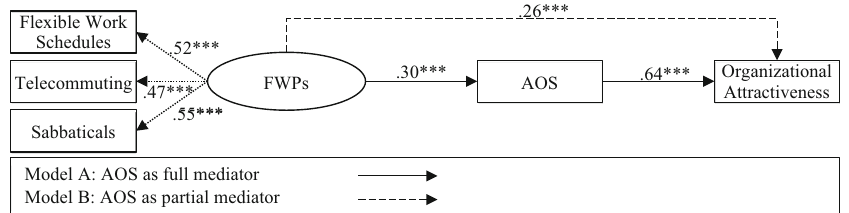
Fig. 3 Model linking FWPs to external outcomes. FWPs flexible work practices, AOS anticipated organizational support; values represent standardized coefficients for model B; *** p \